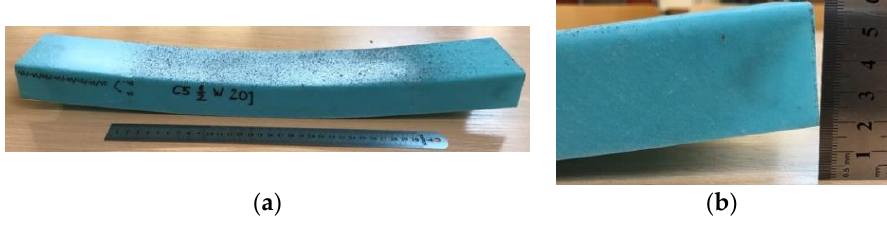
Figure 6. Permanent ( a ) “plastic” deflection in unloaded Cb5 beam with zoom view ( b ).